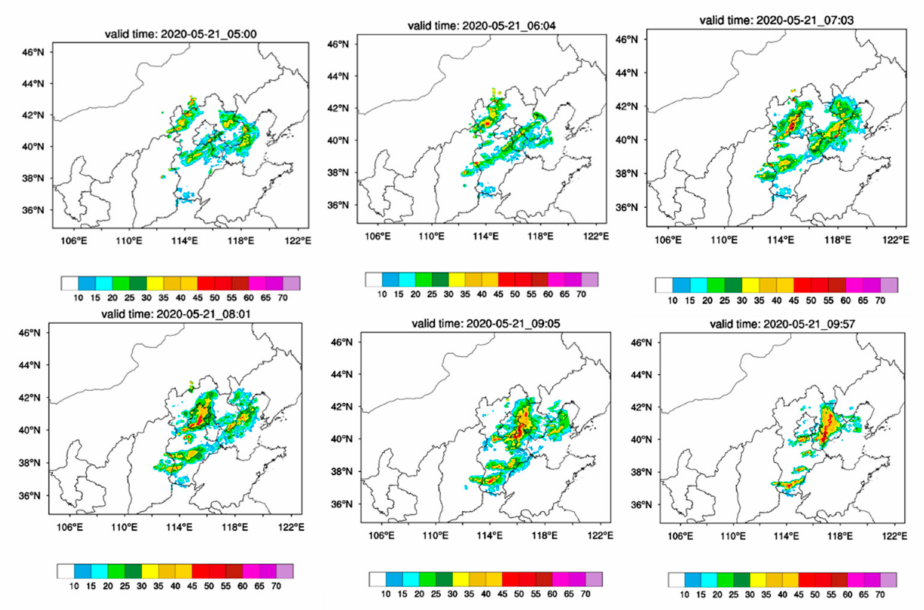
Figure 1. Radar composite reflectivity (CREF) evolution for 05 UTC–10 UTC on 21 May